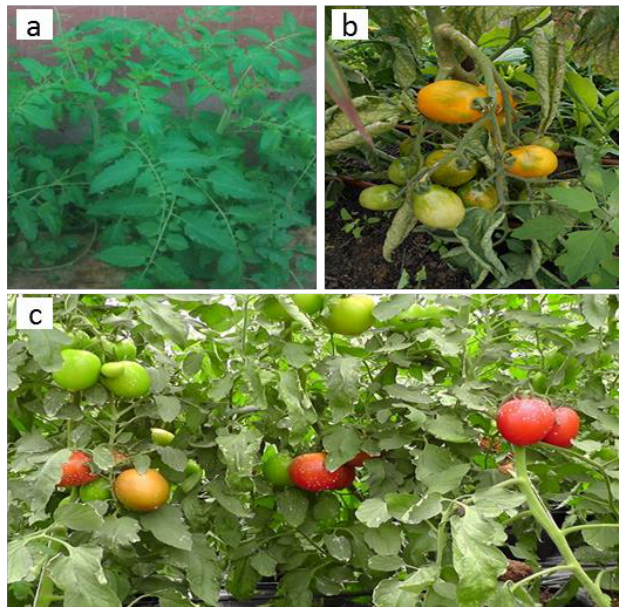
Figure 1: Photograph of L. esculentum Mill. (var. Hausa) (a) Leaves (b) Fruits and; (c) Photograph of L. esculentum (var. Eva F1) leaves and